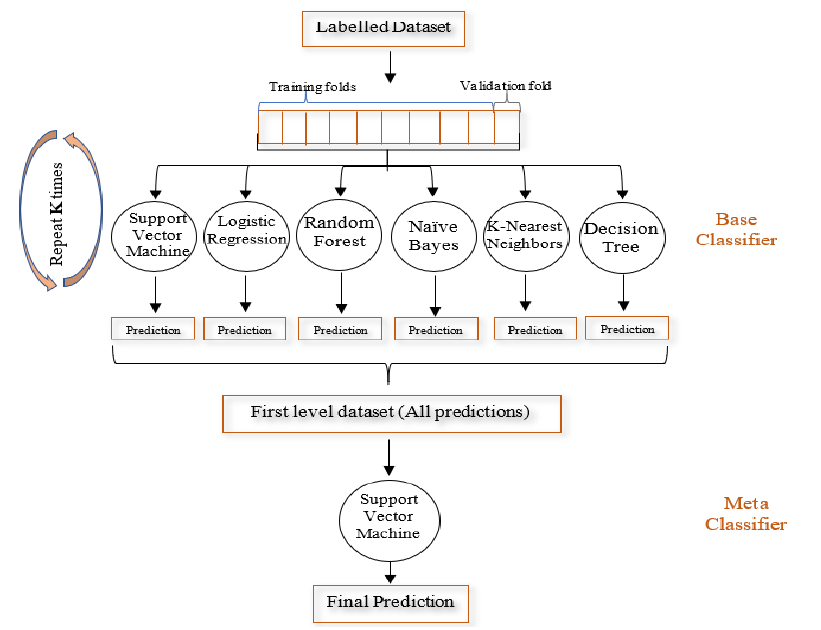
Figure 3. Steps of the ensemble learning.